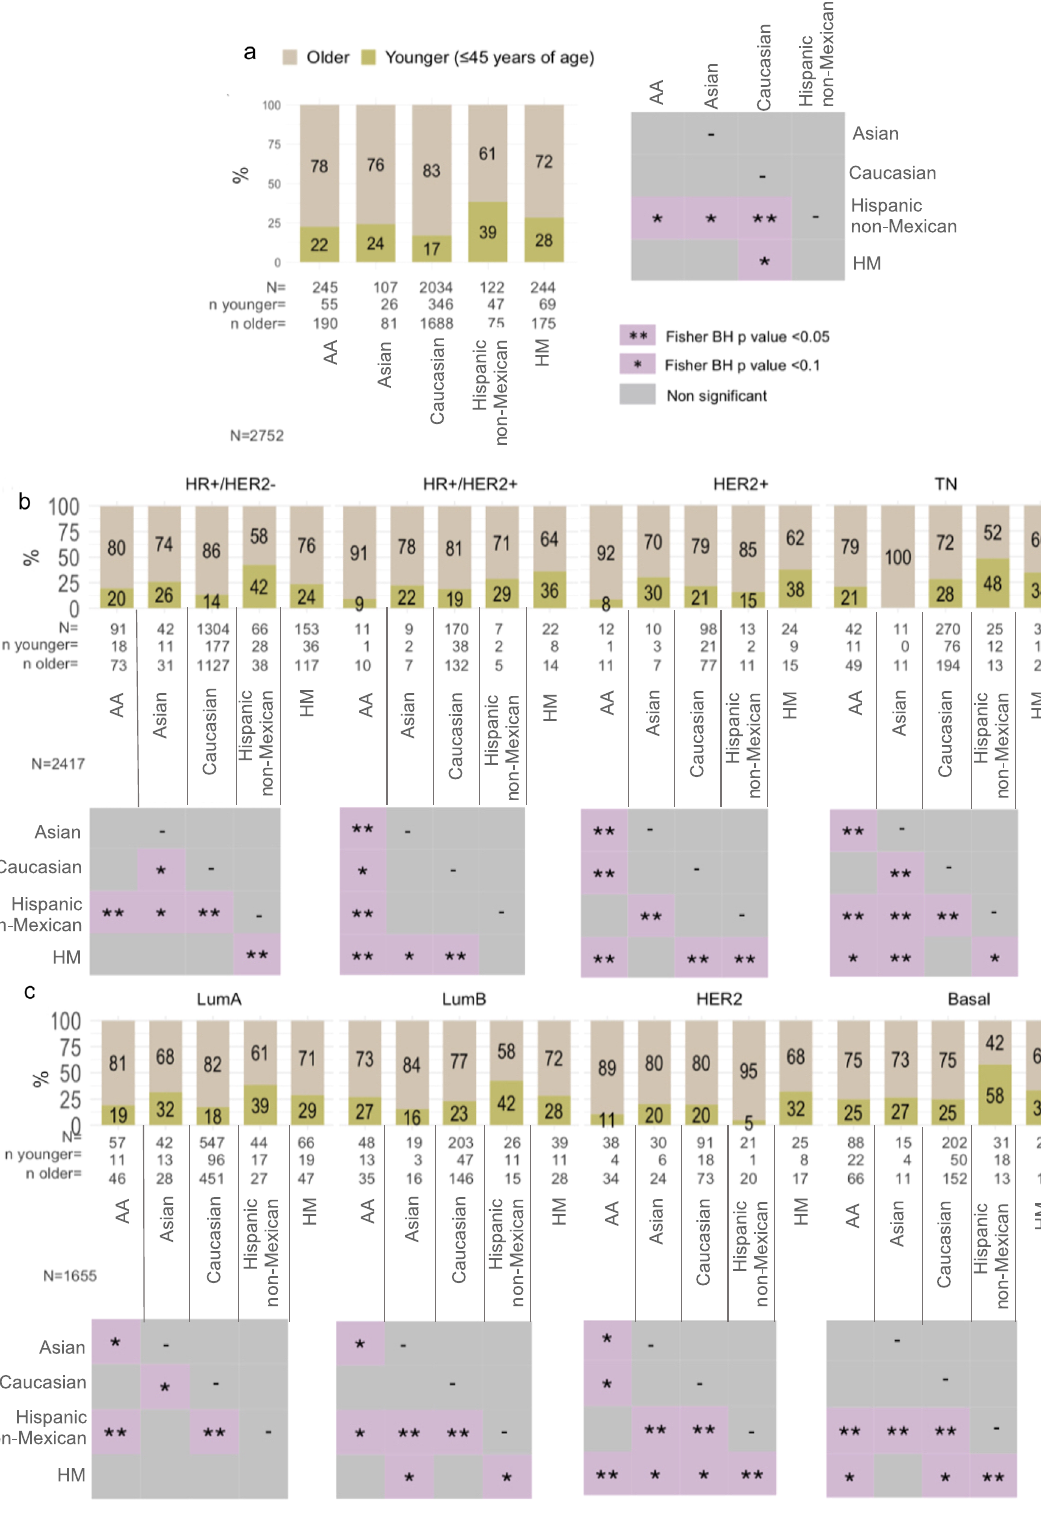
Fig. 2 Age distribution in BC samples from diverse human populations and within IHC and molecular intrinsic subtypes. a Frequency of younger ( ≤ 45 years of age) and elderly (>45 years of age) BC patients among ancestries. Frequency of BC b immunochemistry subtypes, and c PAM50 intrinsic molecular subtypes in patients from different ancestry diagnosis at early-age ( ≤ 45 years of age) or elderly-age (>45 years of age). Barplots represent proportion of age classes in each population group, while heatmaps represent the BH-adjusted p -values computed by a two-sided Fisher ’ s exact test from multiple comparisons. Corresponding p -values are reported on Supplementary Data 2. HM: our pro fi led tumors integrated with GSE75678 Mexican tumors. Hispanic non-Mexican (H nM): Hispanic tumors from GSE16716, GSE78958, and GSE20271. **adjusted p -value < 0.05, *<0.1. HM: Hispanic- Mexican, H nM: Hispanic non-Mexican, AA: African-American, HR: Hormonal receptors (ER and PR).